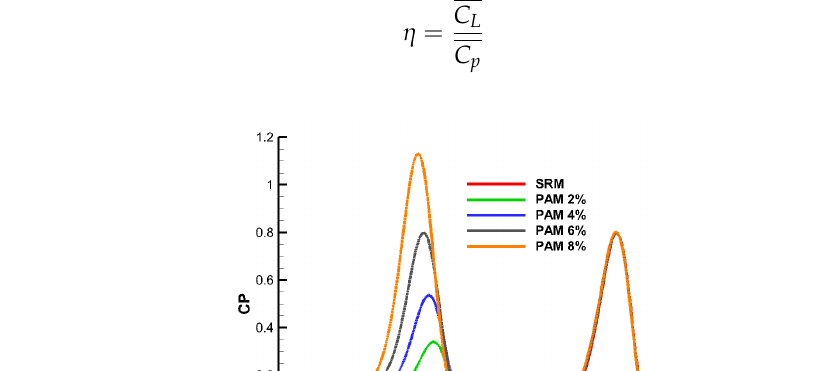
Table 2. Time-averaged aerodynamic parameters for partial advanced mode.